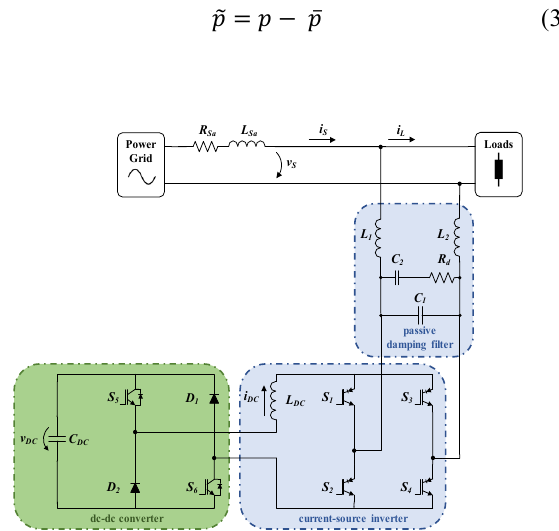
Figure 2. Electrical schematic of the proposed topology of the single-phase SAPF based on current-source inverter with reduced dc-link.